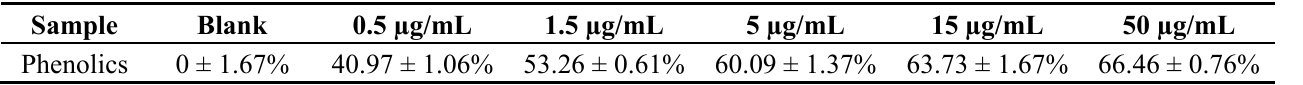
Table 2. Inhibition of total phenolics on HNE